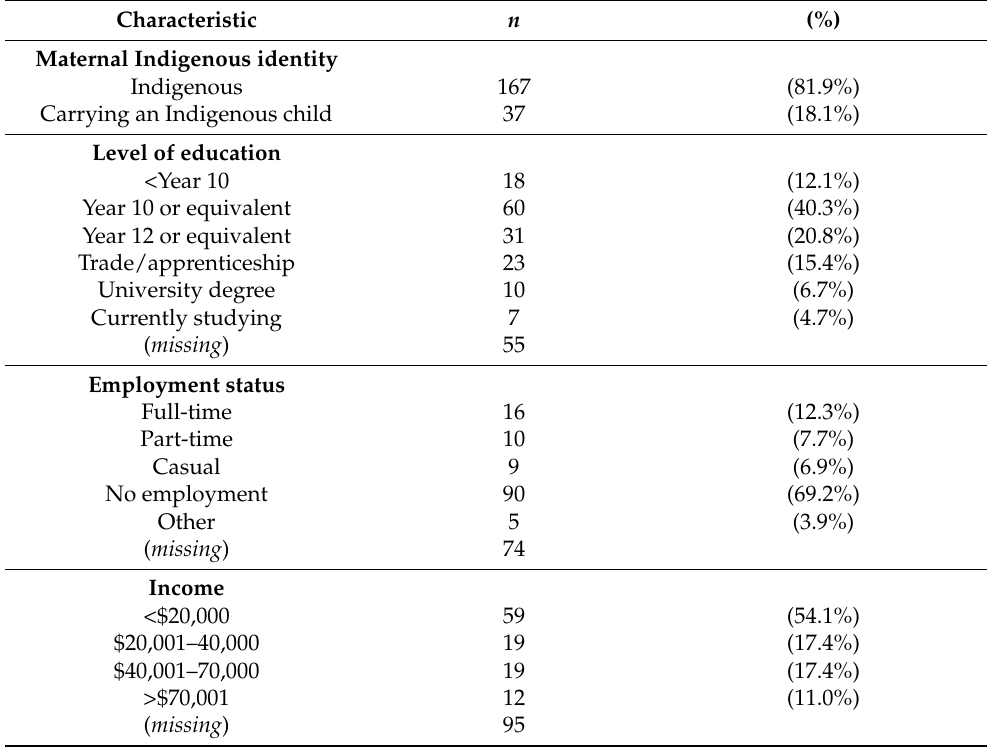
Table 1. Sociodemographic characteristics of pregnant women in the Gomeroi Gaaynggal cohort ( n = 204). Characteristic